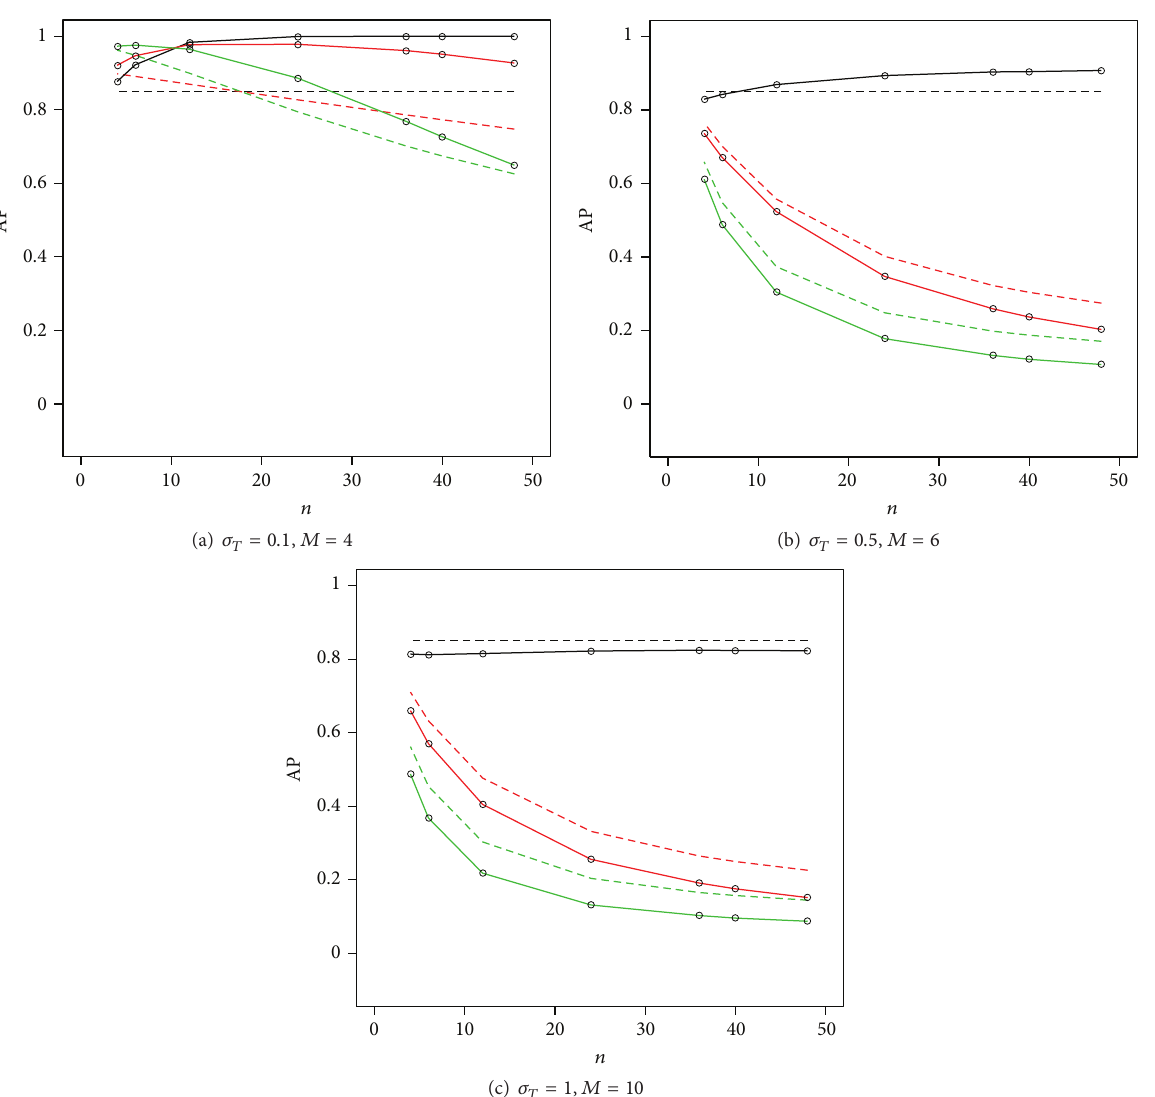
Figure 6: AP for protracted threat using SITMUF joint cusum for 𝑛 = 4,6, 12, 24, 36, 40, 48 . (Colors black, red, and green correspond to Σ Σ 1 – 3 . Dashed lines are for